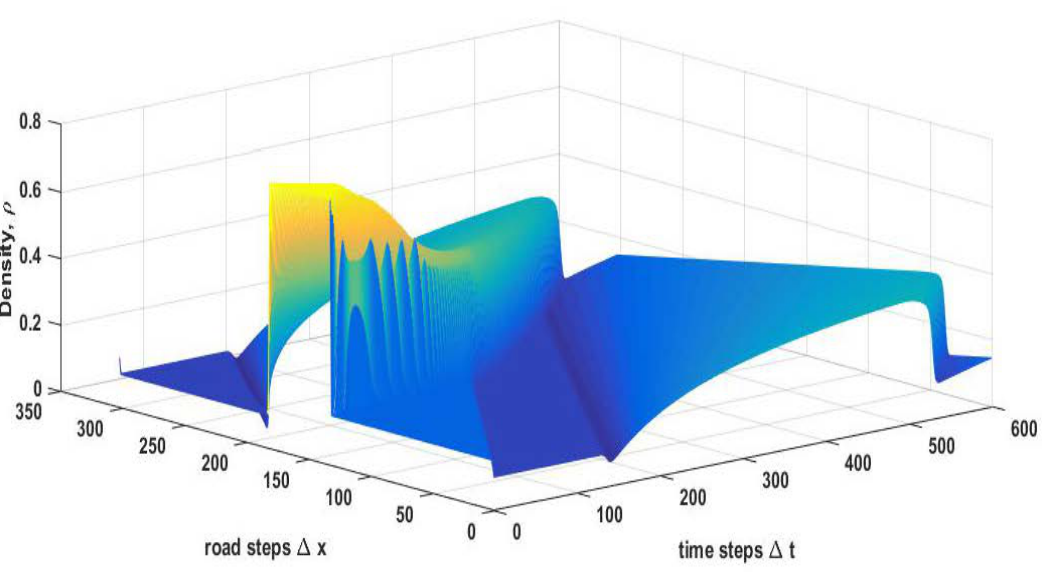
Figure 7. Density behavior with the proposed model during congestion ( ρ > 0.5) over a 300 m circular road for 60 s with τ = 2.5 s and distance headway h = 20 m.